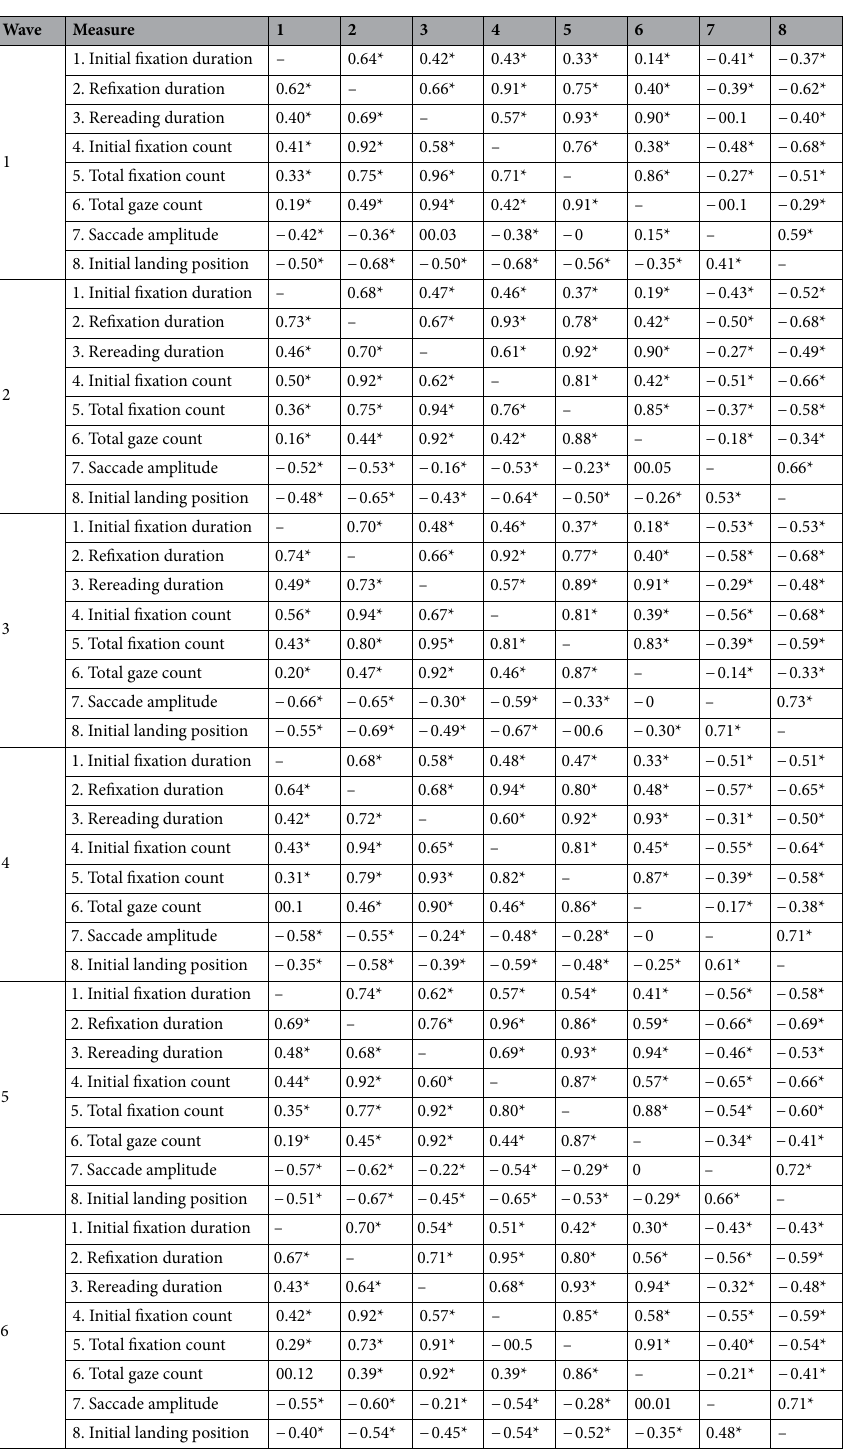
Table 3. Correlations among eye-tracking measures by wave and oral versus silent reading mode. Oral reading correlations on the lower diagonal. Silent reading correlations on the upper diagonal. * p <